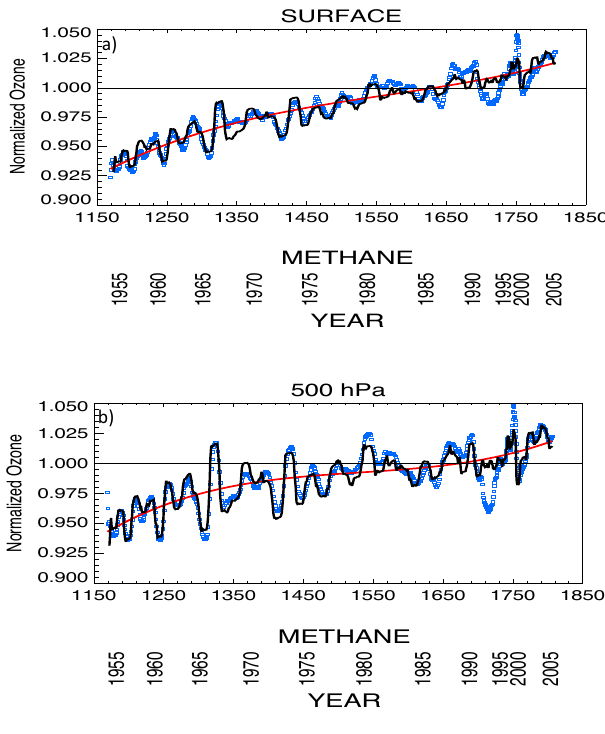
Figure 9. Simulated normalized ensemble mean ozone against global methane concentrations (blue squares), the cubic fit of nor- malized ozone against methane (red line) and the regressed fit (black line). Ozone is averaged from 30 to 90 ◦ N at (a) the surface and (b) 500hPa. The year corresponding to the methane concentra- tions is also